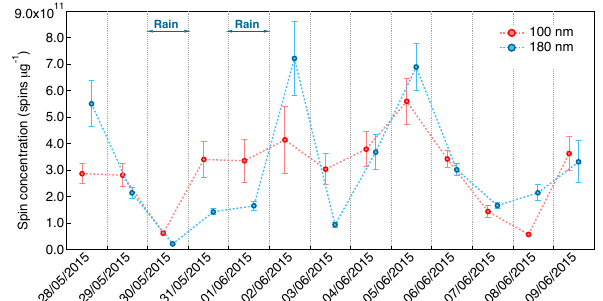
Figure 3. Temporal evolution of concentrations of environmentally persistent free radicals (EPFR) contained in atmospheric aerosol samples with lower cutoff diameters of 100nm (red) and 180nm (blue), measured in Mainz, Germany, during May–June 2015. The error bars represent standard errors based on uncertainties in the particle mass and signal integration of EPR